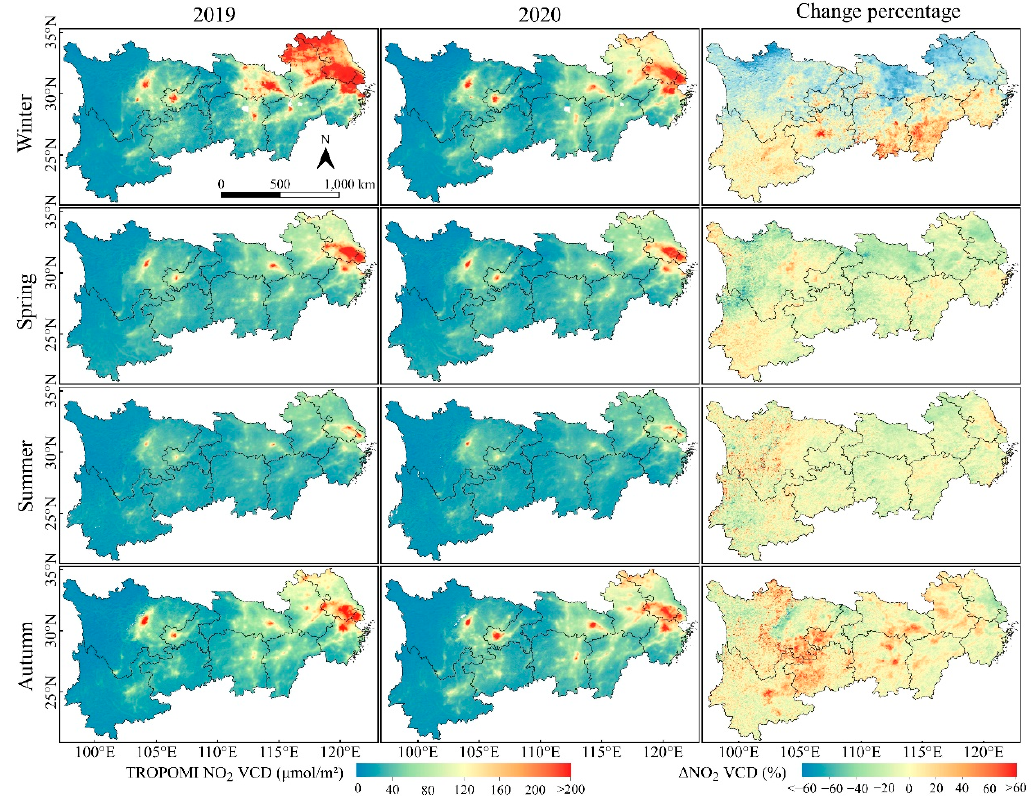
Atmosphere 2021 , 12 , x FOR PEER REVIEW